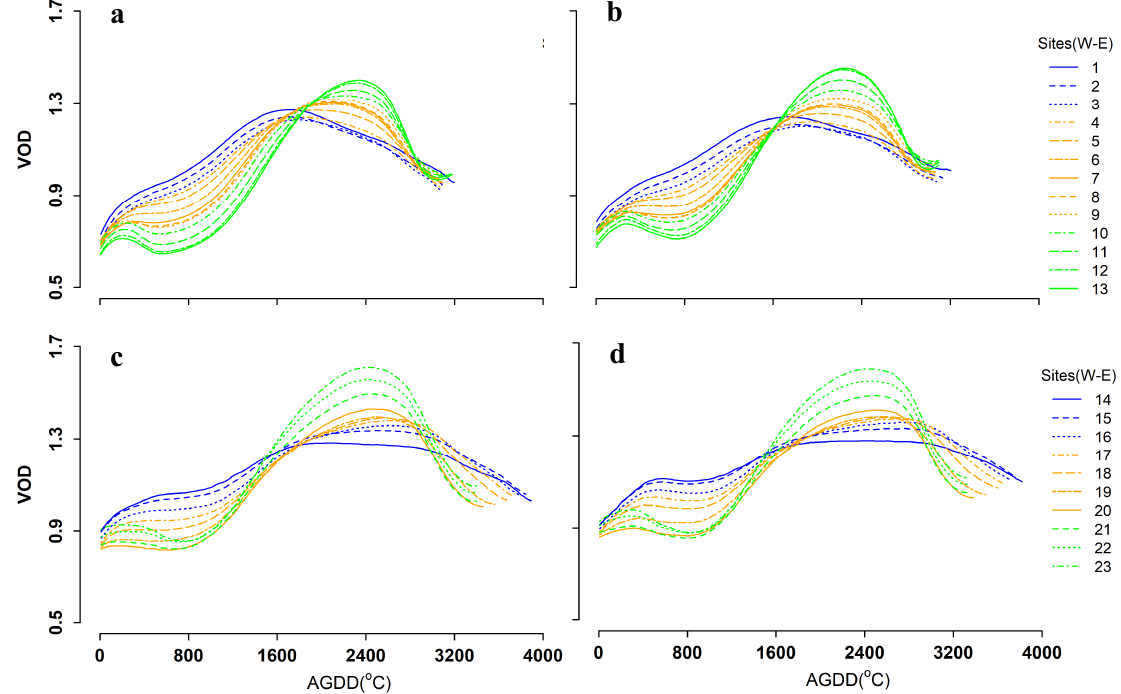
Figure 7. Two groups of annual profiles for average VOD across the study transect AMSR pixels: ( a ) ND and ( b ) SD for 2003–2005 plus 2007; ( c ) ND and ( d ) SD for 2013–2016. Figure line colors follow the scheme described for Figure 6.